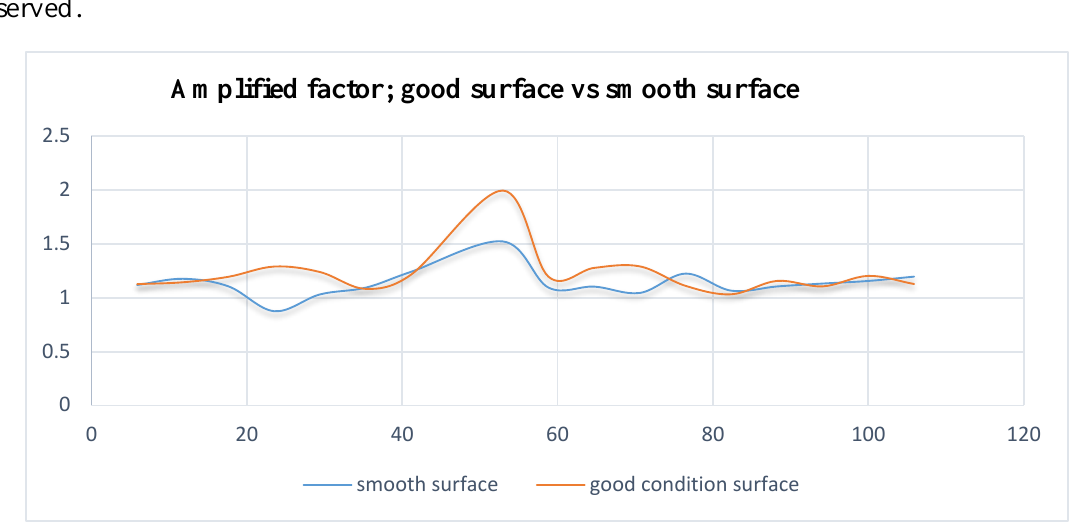
Fig. 5. Amplified factor at different surface conditions.